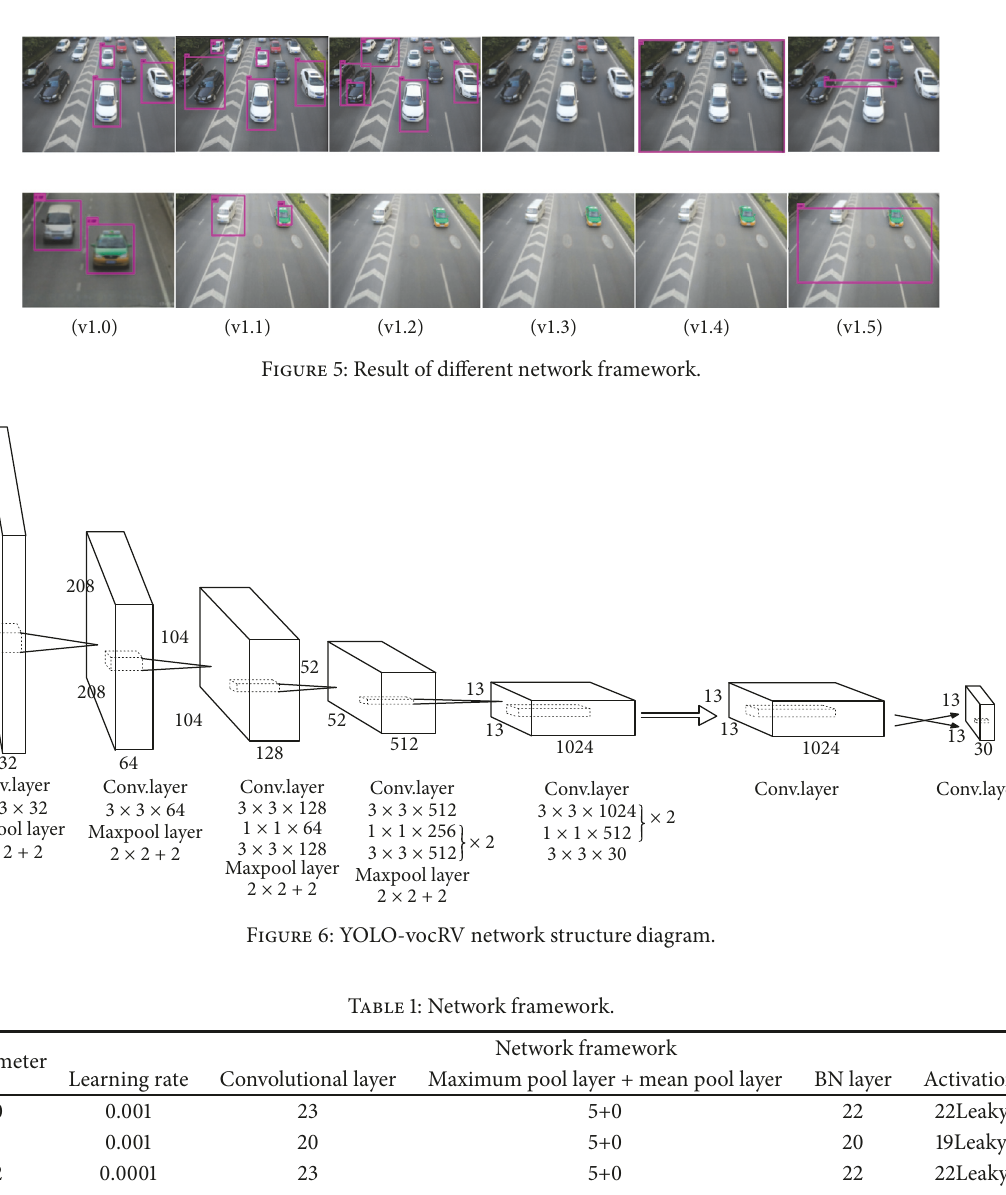
Figure 4: YOLO v2 target detection method diagram.